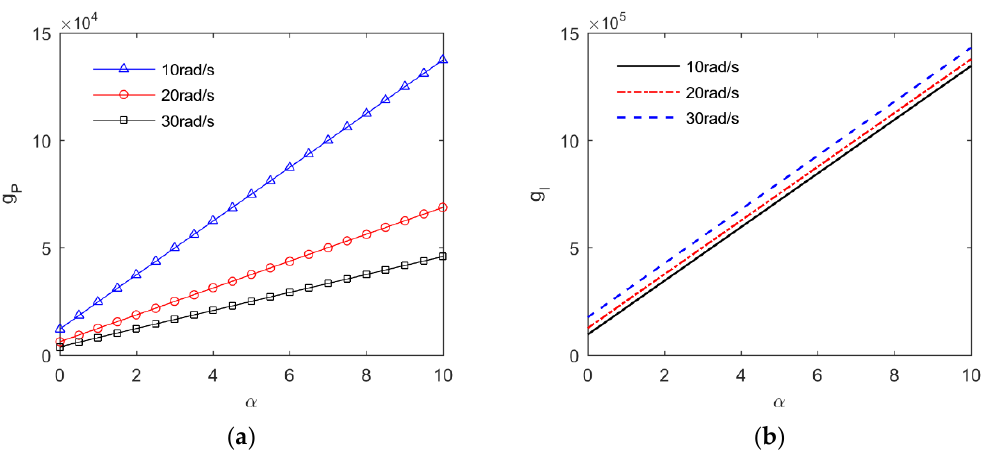
Figure 14. The relationship between control parameters and amplitude ratio: ( a ) The relationship between velocity feedback gain and amplitude ratio; ( b ) the relationship between displacement feedback gain and amplitude ratio. By fitting the experimental data, the relationship between control parameters and the amplitude ratio is obtained as follows.